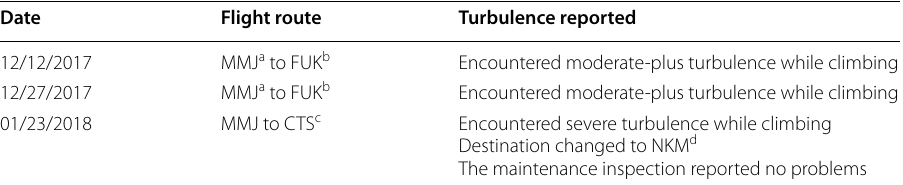
Table 1 Examples of the impact of turbulence on operations